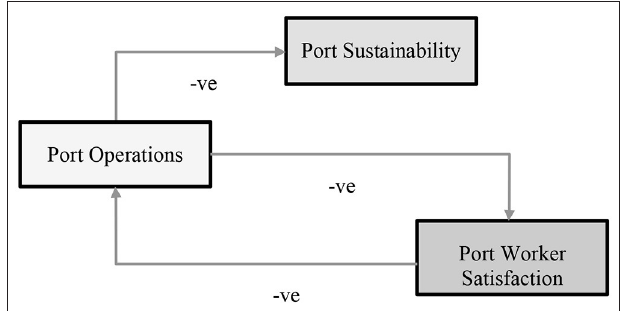
FIGURE 2 | Impact of social satisfaction on port